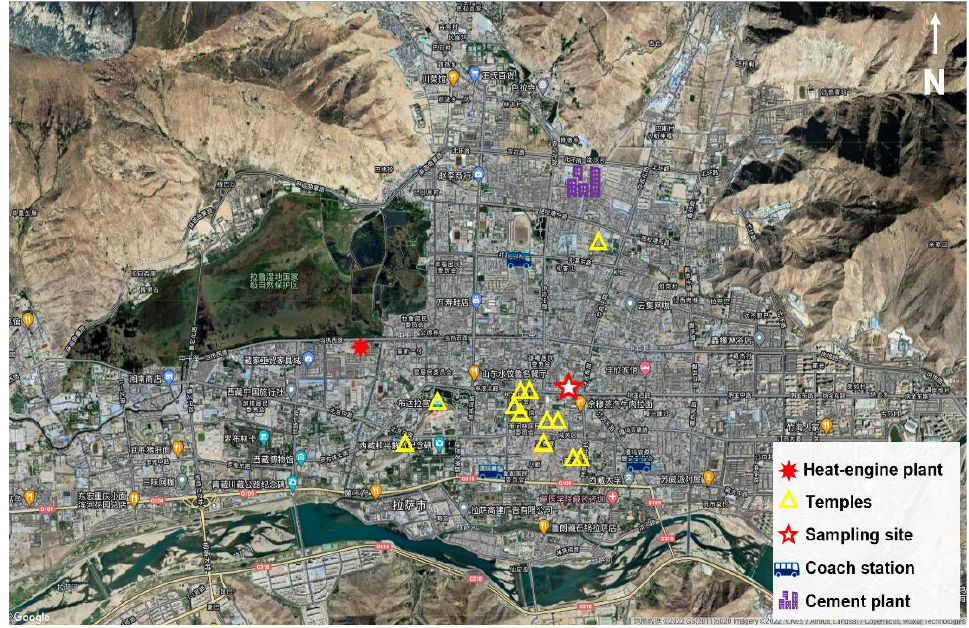
Figure 1. Location map of the sampling site (29°38′ N, 91°38′ E, 3679 m a.s.l.).